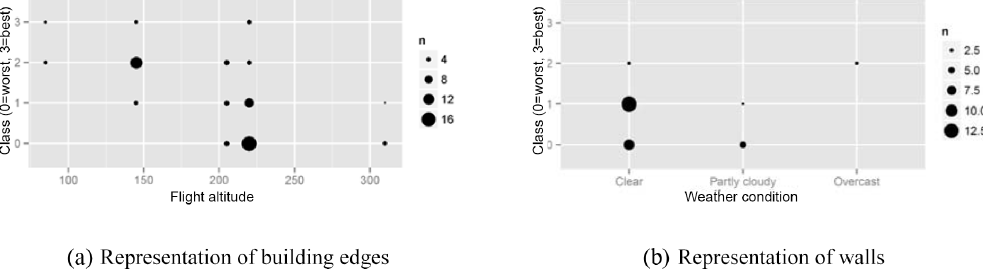
Figure 5. Relationship between the quality of the representation of building edges and flight altitude and between wall representation and weather conditions. The size of the dots is proportional to the number of observed metrics with identical quality class and altitude or weather condition.